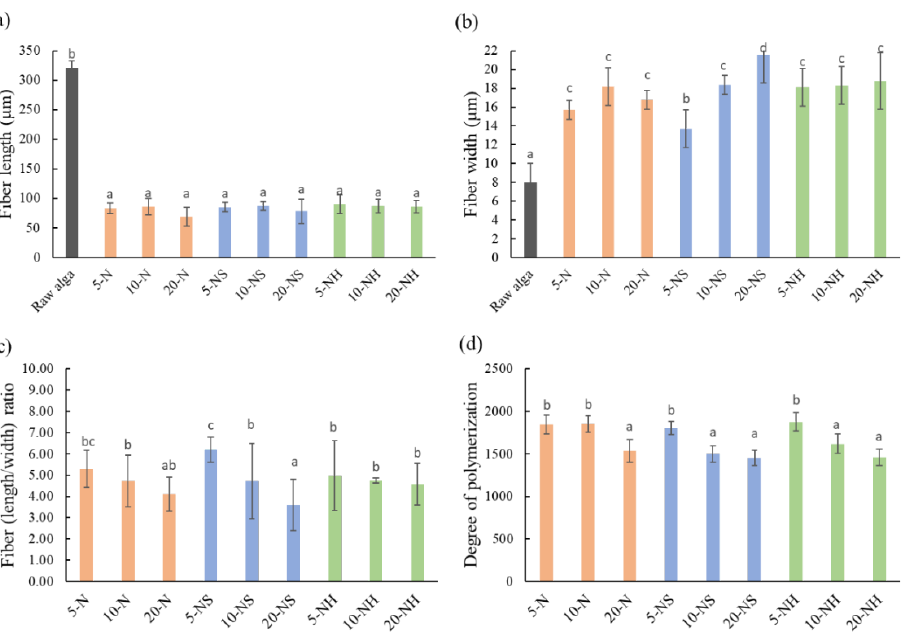
Figure 2. Modification of the Rhizoclonium pulp fiber ( a ) length, ( b ) width, ( c ) ratio of length/width, and ( d ) degree of polymerization after cooking and beating treatment. Raw material without cooking and beating treatment. Letters indicate a significant difference within each experiment at p < 0.05 in comparison.